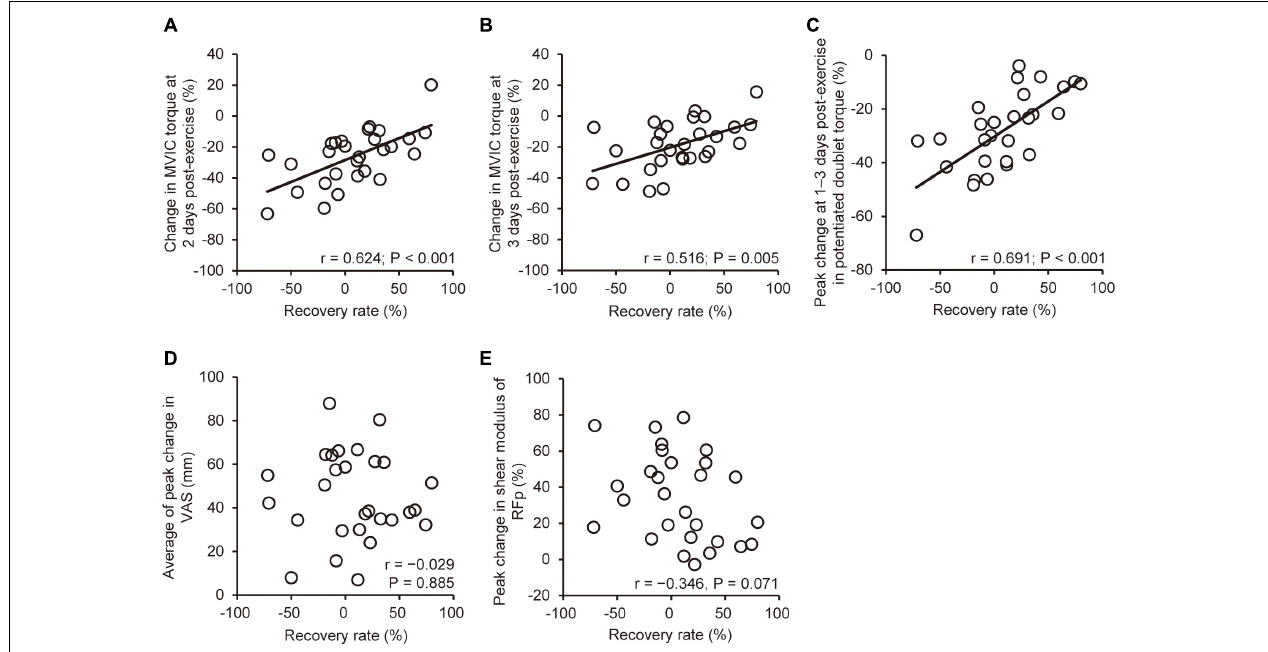
FIGURE 4 | Correlations (Pearson r , n = 28) between the recovery rate of maximal voluntary isometric contraction (MVIC) torque from immediately to 1-day post-exercise and the change in MVIC torque from baseline to 2 (A) and 3 days post-exercise (B) , peak changes at 1–3 days post-exercise in potentiated doublet torque (C) , average muscle soreness (D) assessed by a visual analog scale (VAS, a 100-mm line), and shear modulus (E) of the rectus femoris in the proximal region